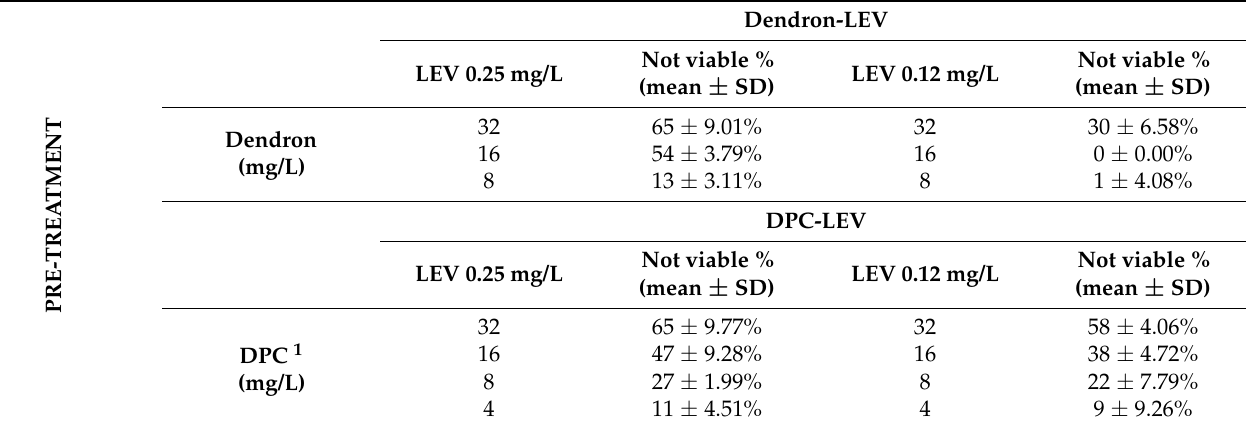
Table 2. Percentage of non-viable biofilm cells for the different combinations of Dendron-LEV vs. DPC-LEV in the pre-treatment of S. aureus biofilm (inhibition of biofilm